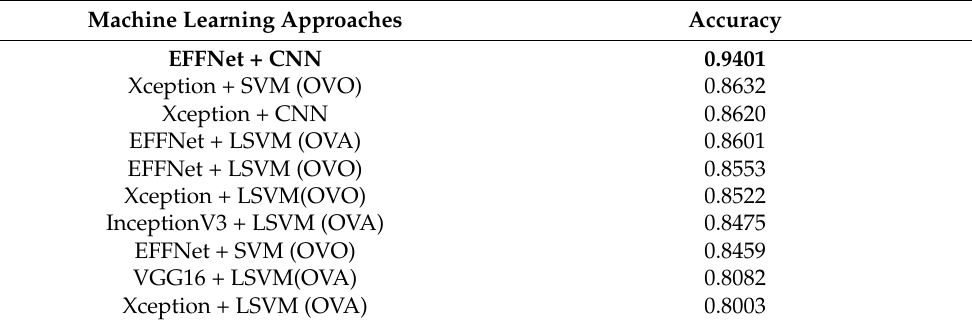
Table 16. The ten highest performing machine-learning approaches for Sabah Food Dataset.